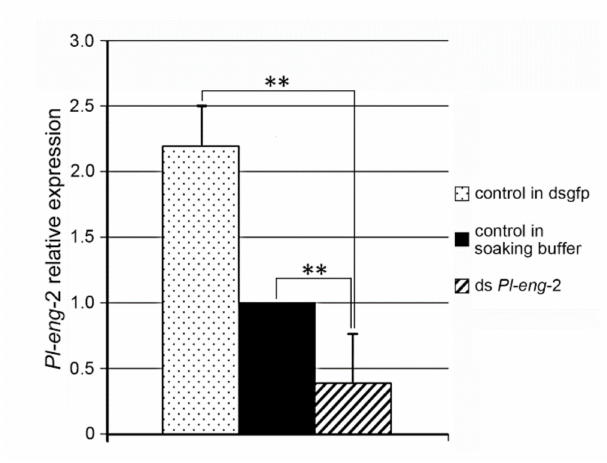
Figure 5. Relative expression level of Pl-eng -2 in nematodes after soaking in the green fluorescent protein gene dsRNA ( dsgfp ) control, in nematodes soaked in soaking buffer and in nematodes soaked in the target ds Pl-eng -2 by using real-time quantitative PCR. Bars indicate standard errors of the mean data ( n = 3). Significant differences were found between the controls and treated nematodes (** p < 0.01).